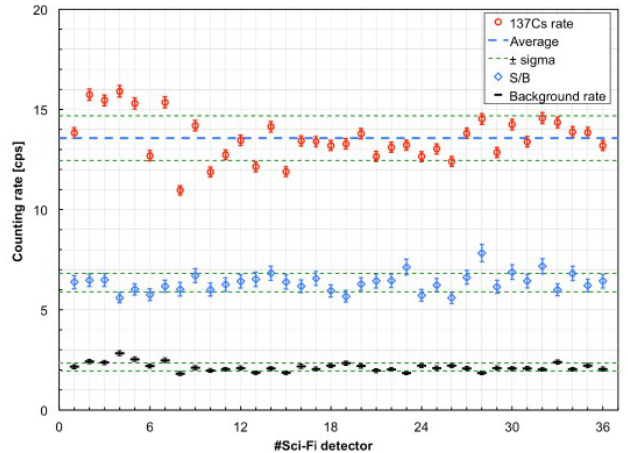
Fig. 9. The counting rate measured with the 137 Cs the background rate and the signal to background ratio of the 36 SciFi detectors.